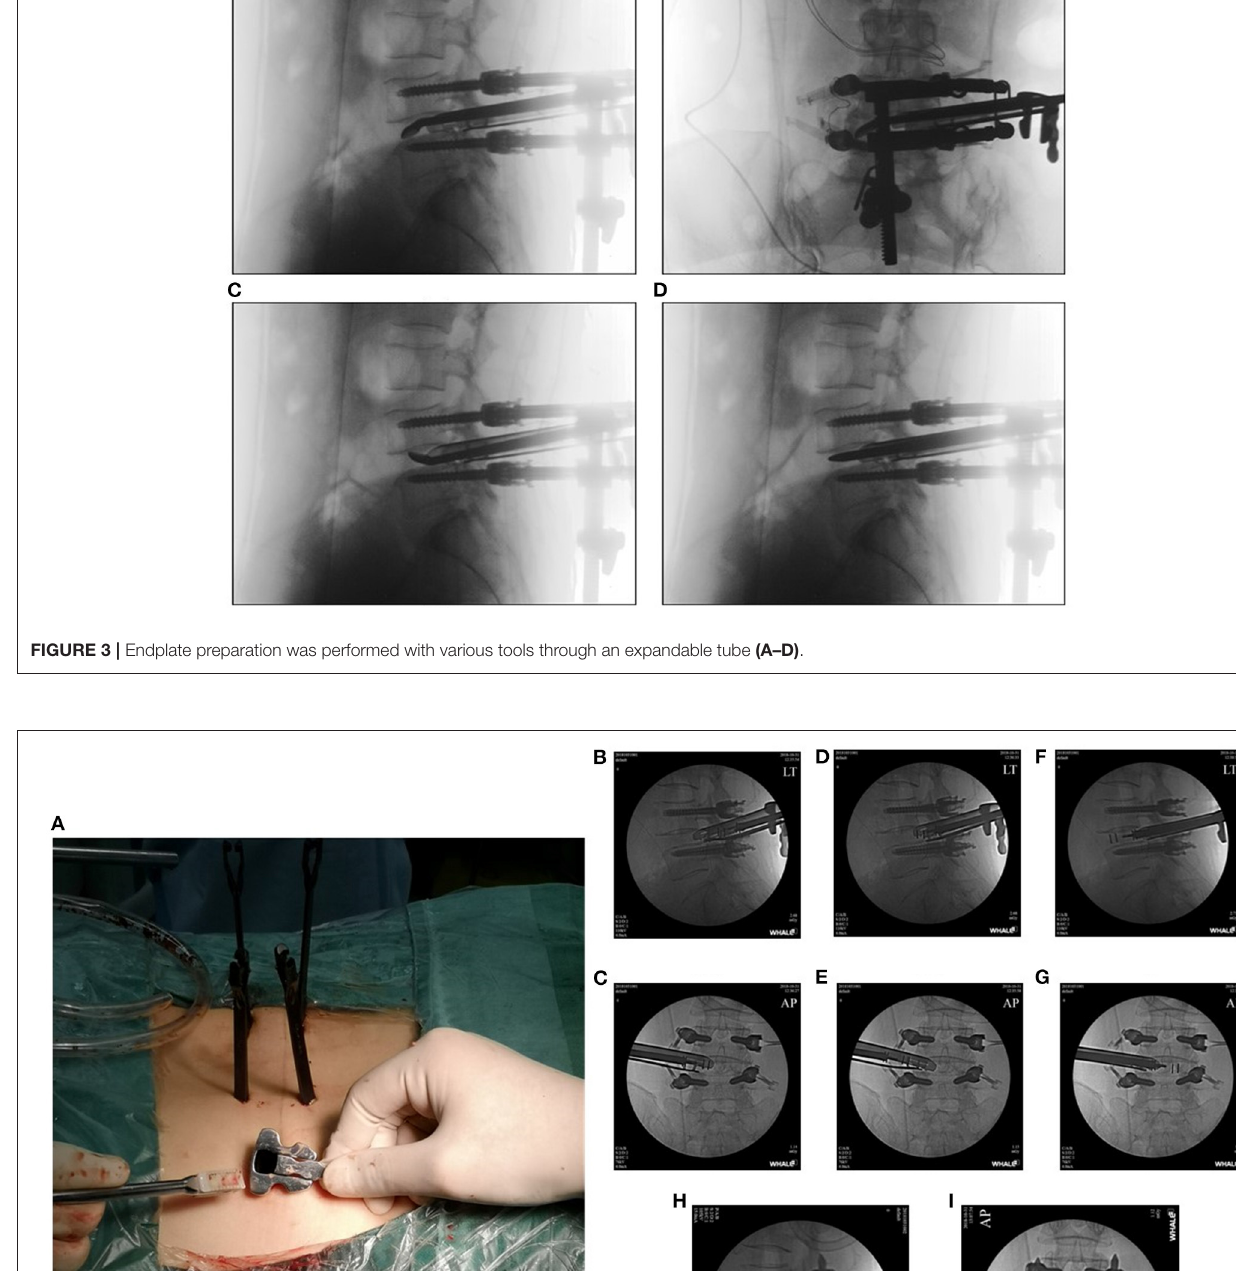
Frontiers in Surgery |